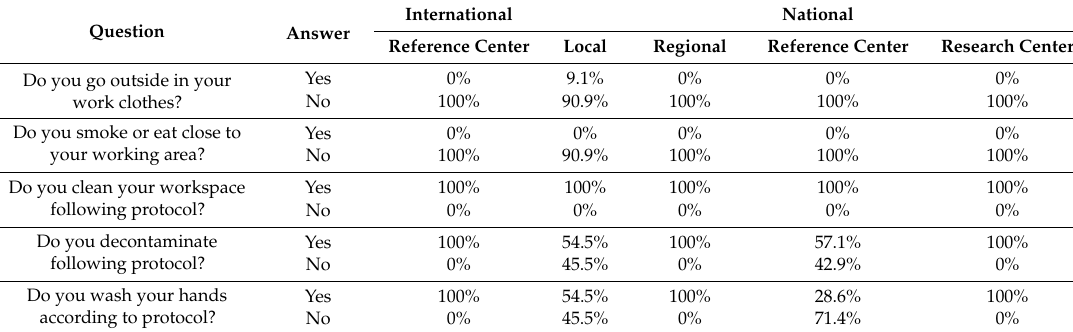
Table 4. Frequency of occupational safety